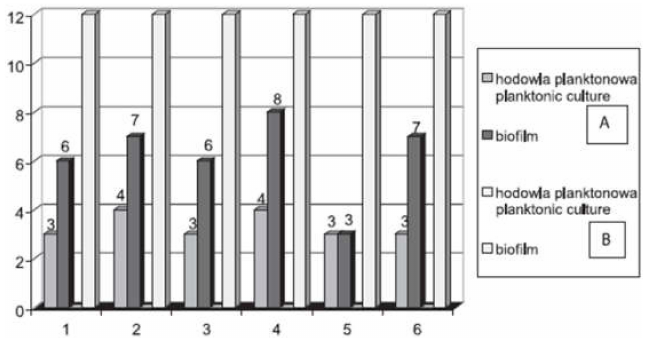
Figure 4. Survival of bacteria in the planktonic culture and the biofilm by antibiotic and antiseptic used (MIC). A—octenidine hydrochloride, B—gentamicin [36]. The publication “Adhesion of staphylococcus epidermidis cells on Ti6Al4V titanium